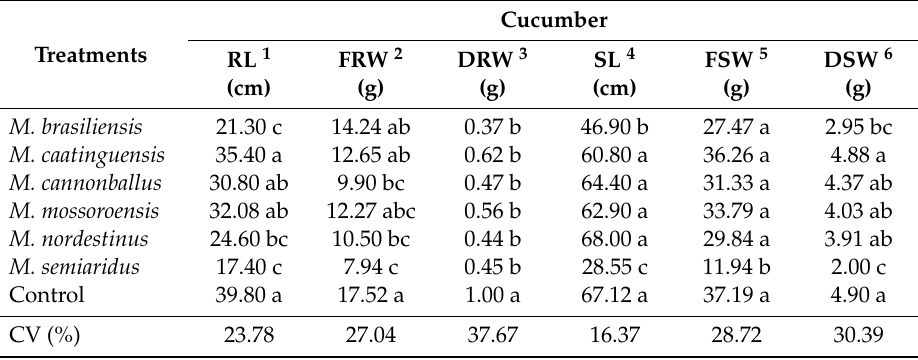
Table 3. E ff ect of Monosporascus spp. inoculation on root and shoot length, fresh root and shoot weight, and dry root and shoot weight, of cucumber, melon, pumpkin and watermelon